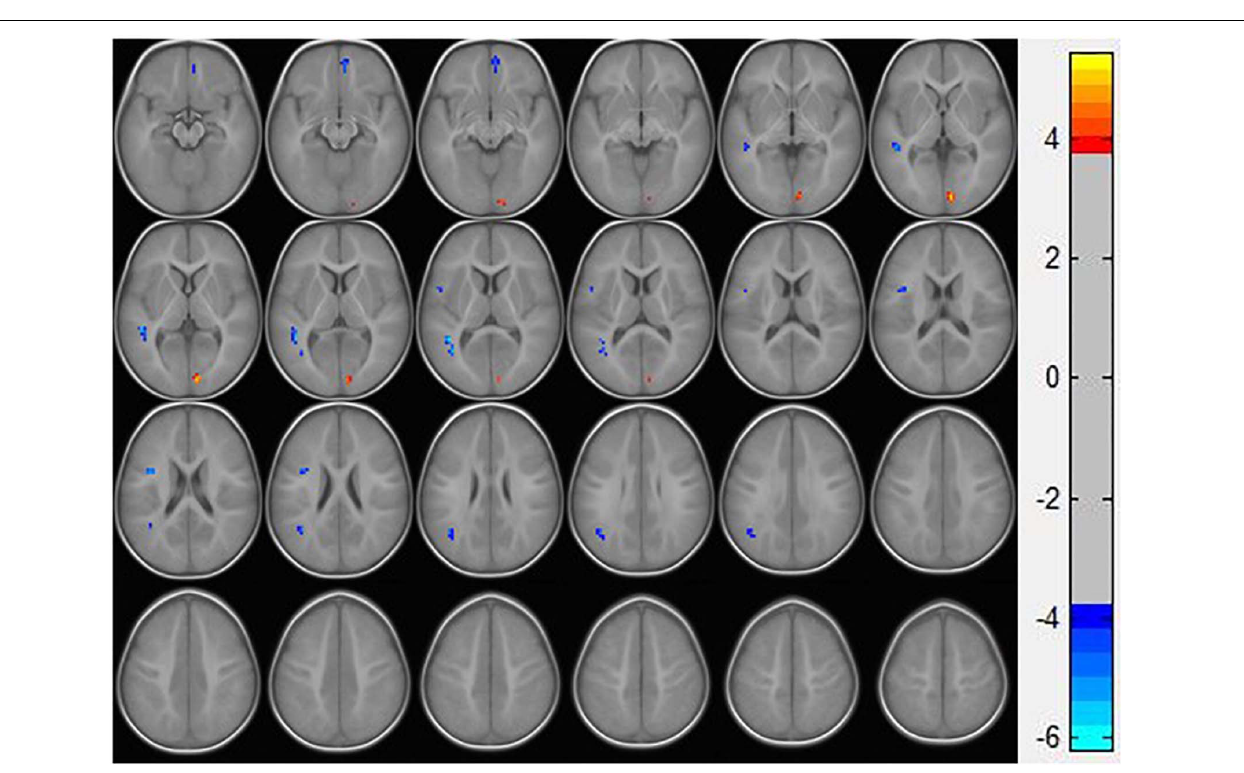
FIGURE 1 | Statistically significant differences between ASD boys and TDs are shown in a ReHo map of the whole brain with MRI. The ASD boys showed a significant ReHo increase in the right calcarine (warm colors) as well as a decrease in the opercular part of the left inferior frontal gyrus, left middle temporal gyrus, left angular gyrus, and right medial orbital frontal cortex with decreased ReHo values (cold colors). A T-score bar is shown on the right. Warm and cold colors denote increases and decreases in ReHo,